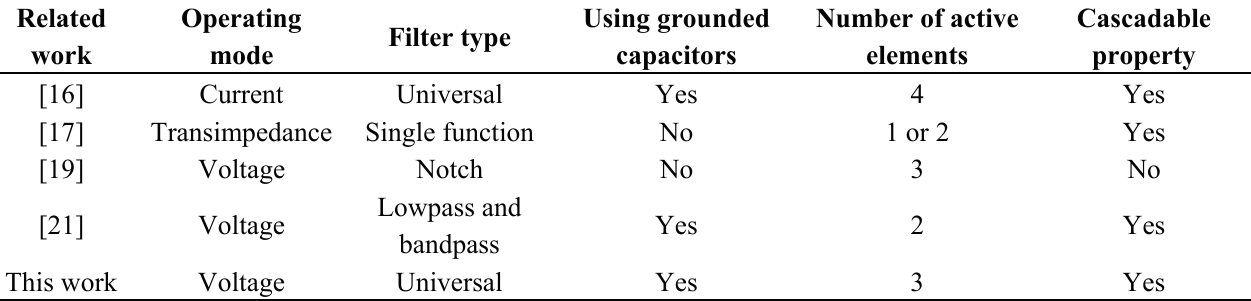
Table 3. Comparison of the obtained filter of related